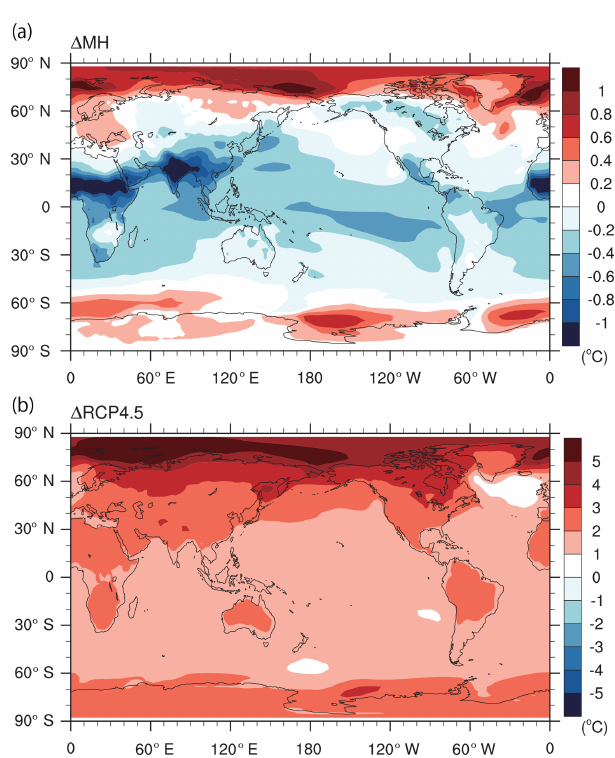
Figure 1. Multi-model mean (all 10 models listed in Table 2) an- nual mean surface air temperature response ( ◦ C): (a) (cid:49) MH and (b) (cid:49)